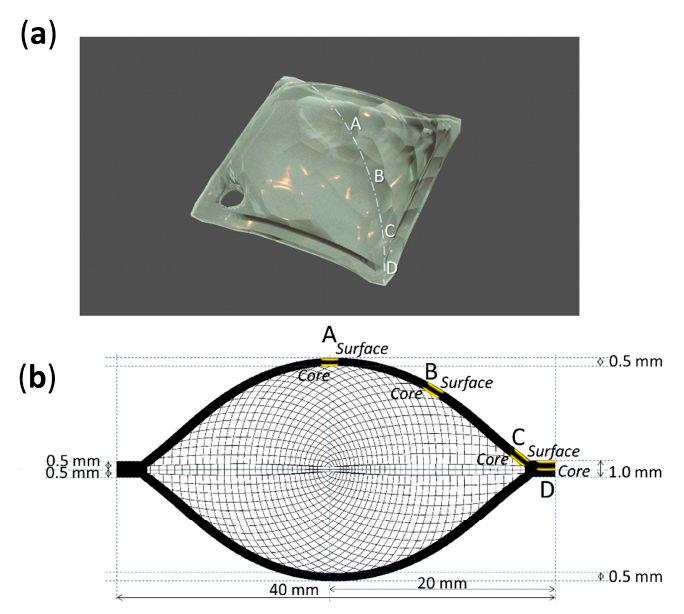
Figure 5. Sampling points ( a ) and depths ( b ) of 13-day aged sheets.